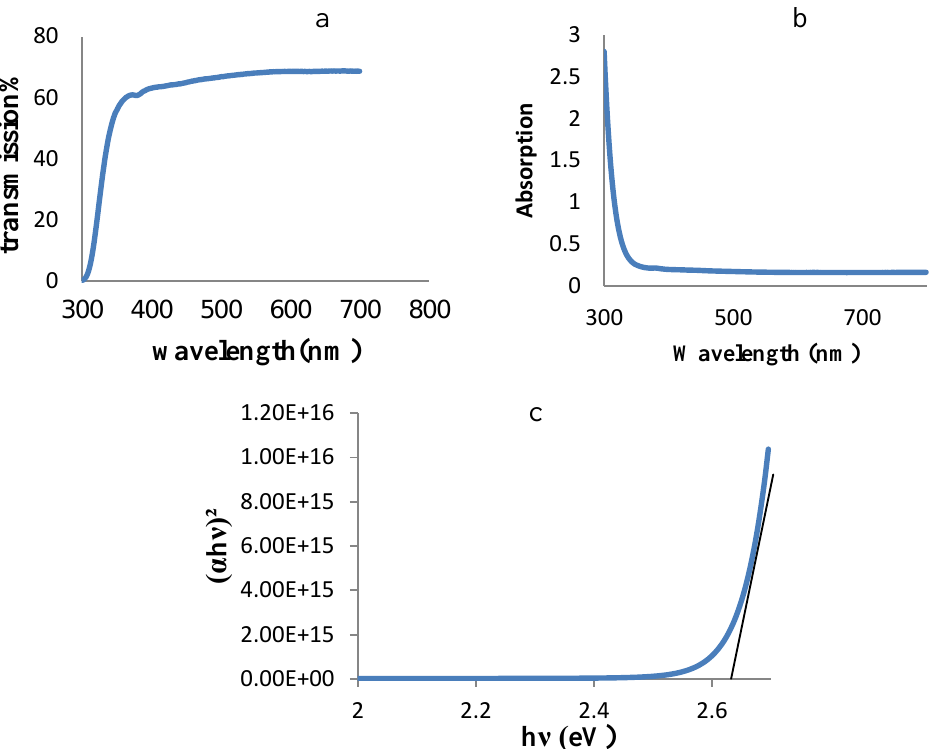
Fig 4: Plot of optical properties of deposit thin copper oxide a – Transmission, b- Absorption and c – Energy band gap.